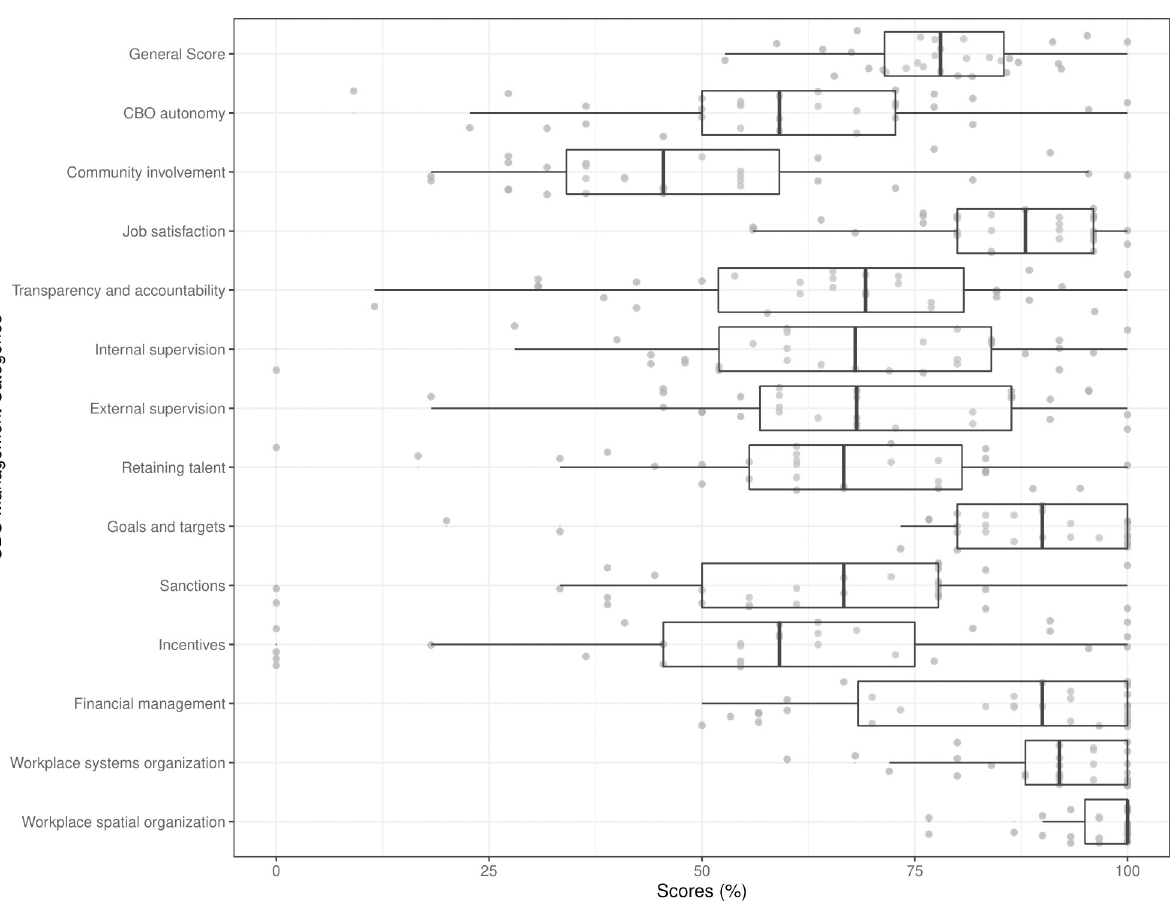
Fig 6. Management scores for community-based organizations providing HIV prevention services in Nigeria in 2016 (n = 31).